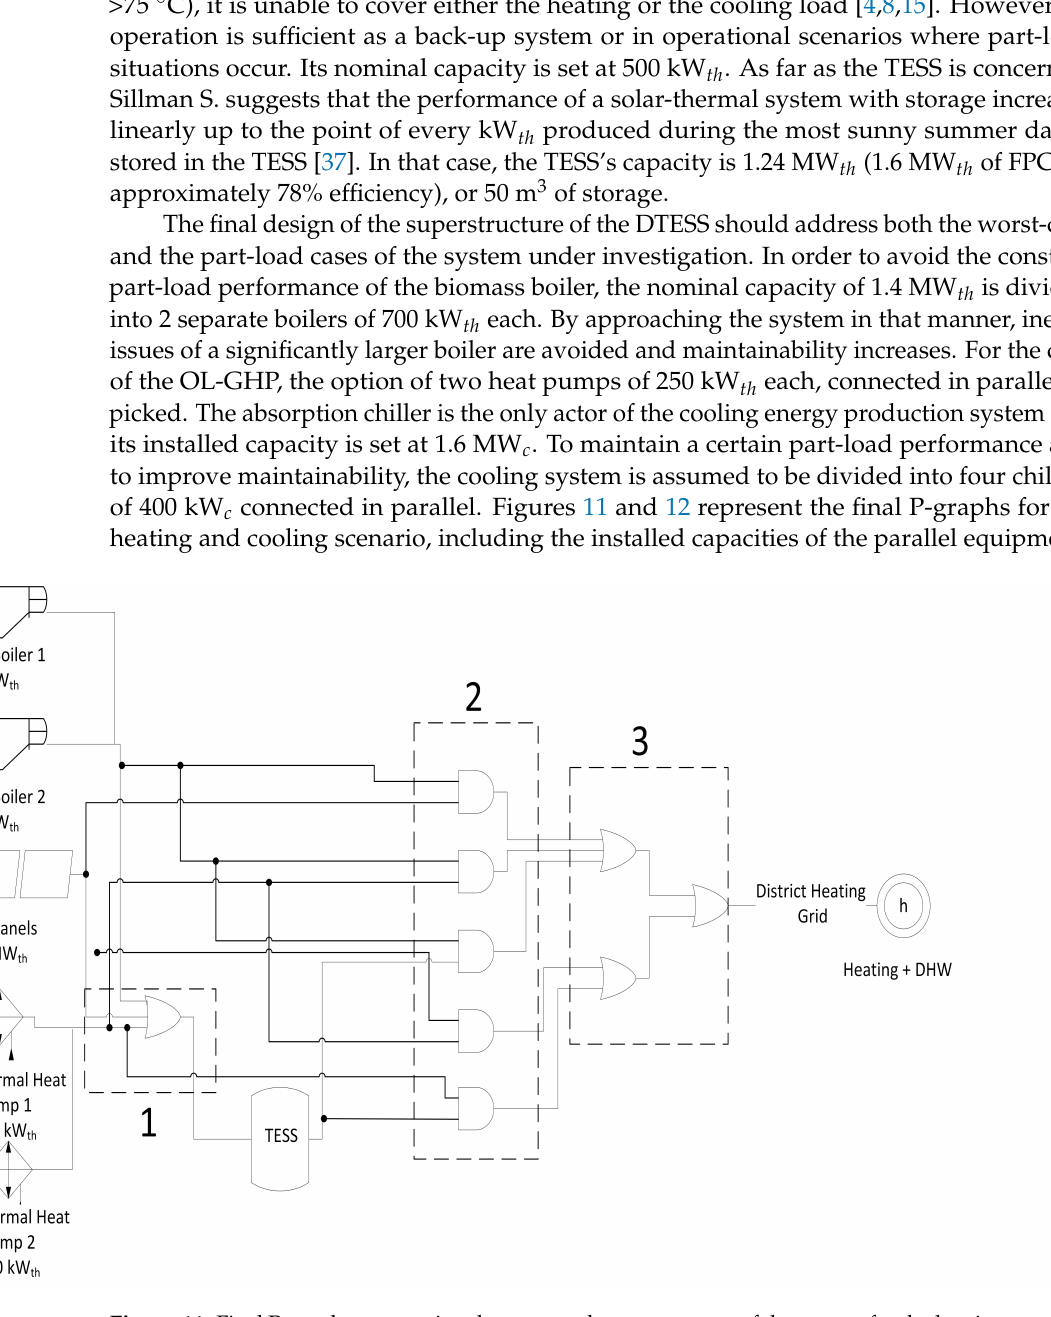
Figure 11. Final P-graph representing the proposed superstructure of the system for the heating